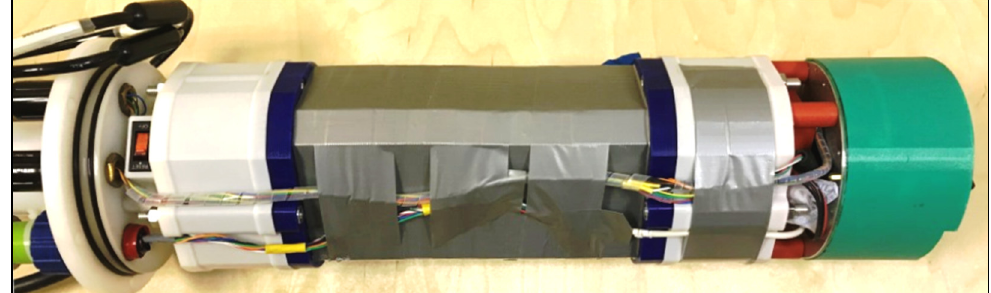
Figure 7. Battery and MCU that are mounted on the housing end cap. The MCU is protected by a plastic shield (green colored). The rechargeable battery with a protection circuit board is covered by thermal adhesive tape.